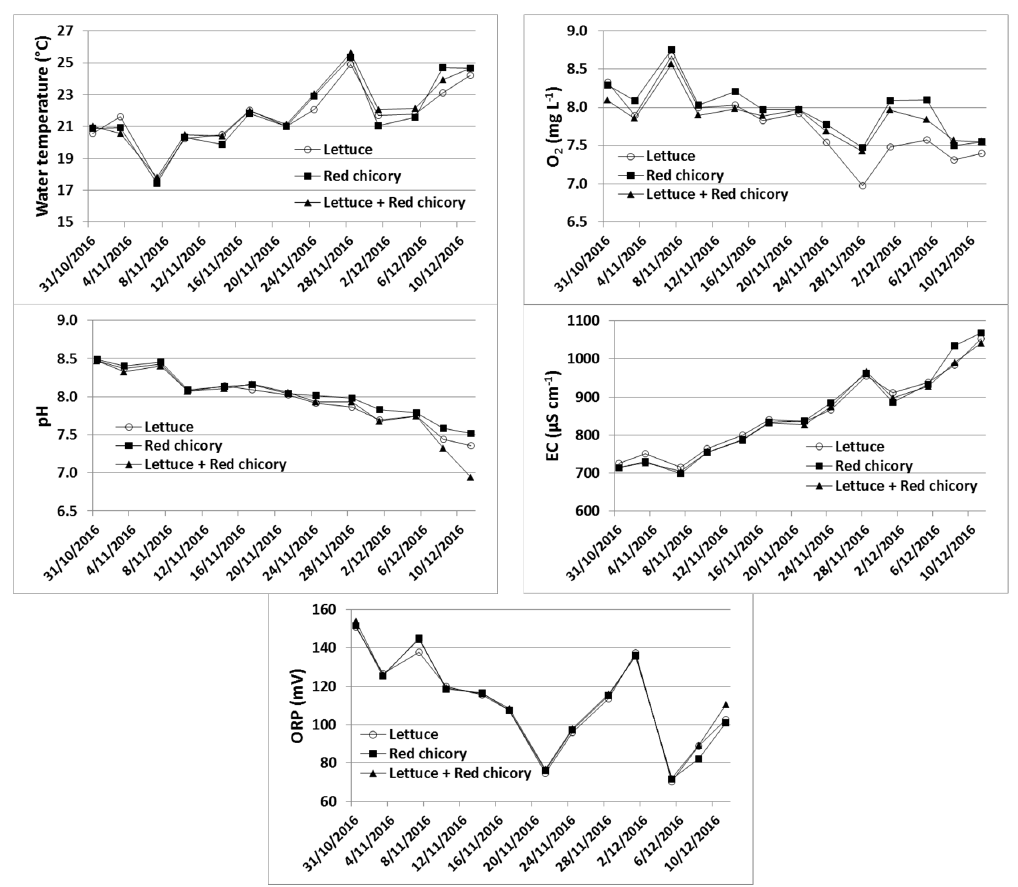
Figure 1. Water temperature, dissolved oxygen (O 2 ), pH, electrical conductivity (EC) and redox potential (ORP) in differently planted aquaponic systems during the study period.